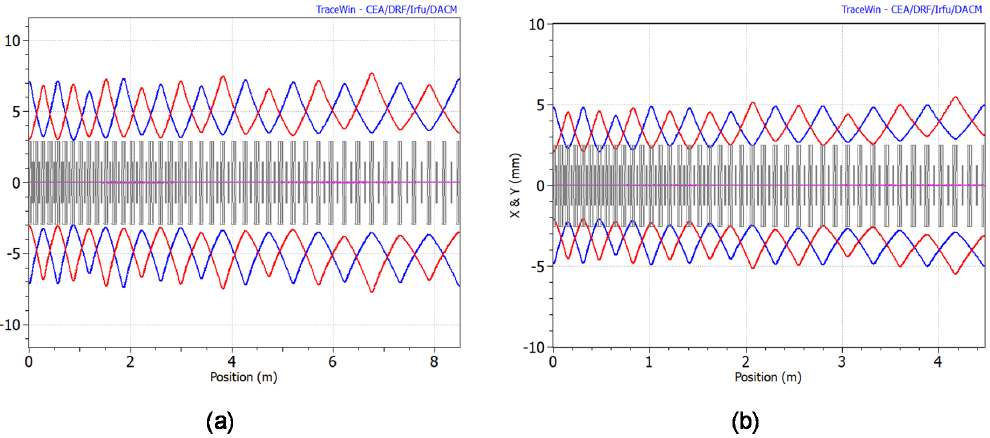
Figure 11. Transverse beam 3 * RMS envelopes (X in blue and Y in red) along both DTL linacs: ( a ) 162.5 MHz design, ( b ) 325 MHz design.